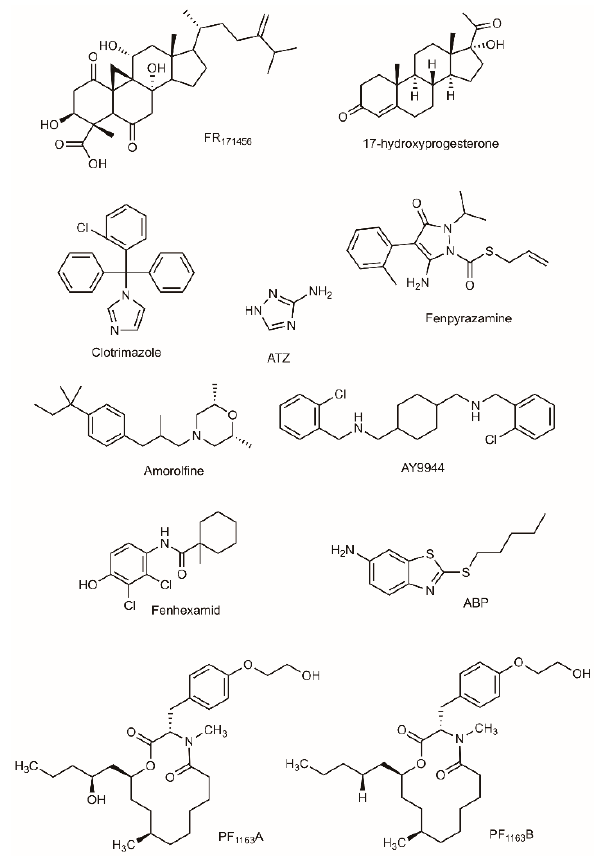
Figure 5. Chemical inhibitors for C4 ‐ SBI accumulation.